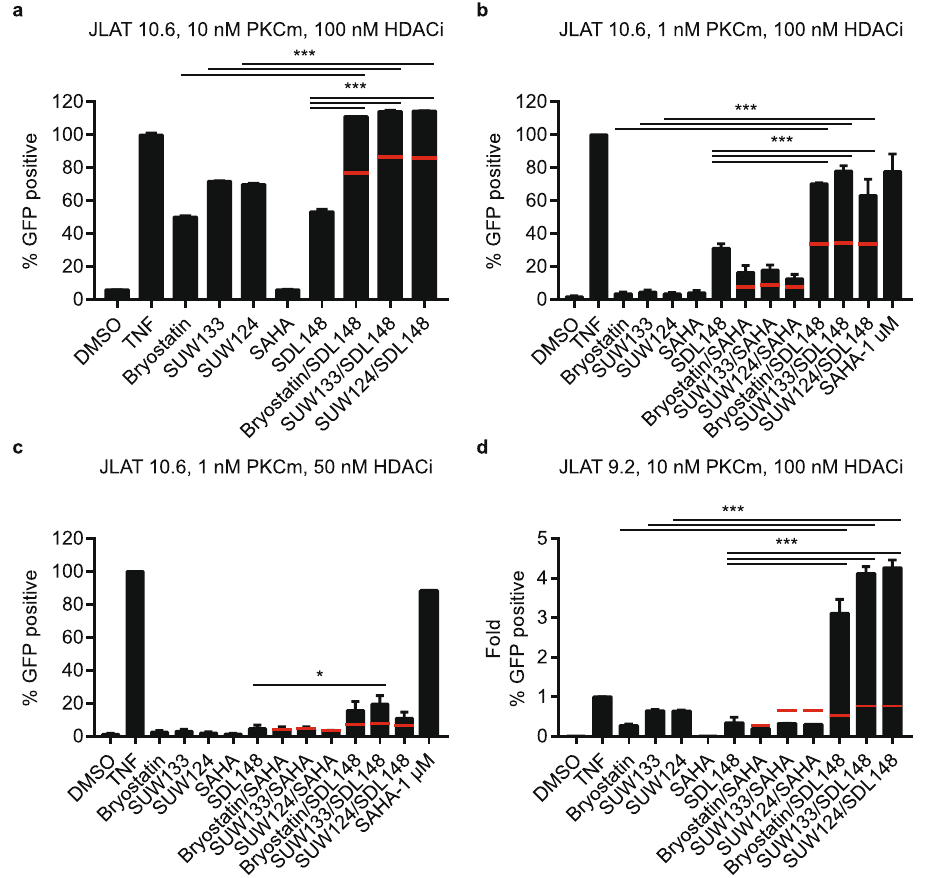
Figure 6. Largazole combinations with bryologs show synergy and unprecedented potency as HIV latency reversing agents. JLAT cell lines were incubated with different concentration combinations of LRAs. The percent of GFP positive cells was analyzed by FACS and the degree of HIV-1 reactivation was normalized to TNF- α . 10 ng/mL TNF- α was used as the positive control. JLAT 10.6 cells ( a – c ) and JLAT 9.2 cells ( d ) were incubated for 18–24 h with ( a ) 10 nM PKC modulator (PKCm) and 100 nM HDAC inhibitor (HDACI) concentrations, ( b ) 1 nM PKCm and 100 nM HDACI, ( c ) 1 nM PKCm and 50 nM HDACI, ( d ) 10 nM PKCm and 100 nM HDACI. Panel ( d ) presented as a fold change relative to TNF-a. Data indicate mean values of experiments in duplicate (Fig. 4a) or triplicate (Fig. 4b–d) and error bars represent mean ± s.e.m. (n ≥ 3). * p < 0.05, *** p < 0.001 (ANOVA). Red-coloured dashes indicate the predicted fractional response based on the Bliss independence